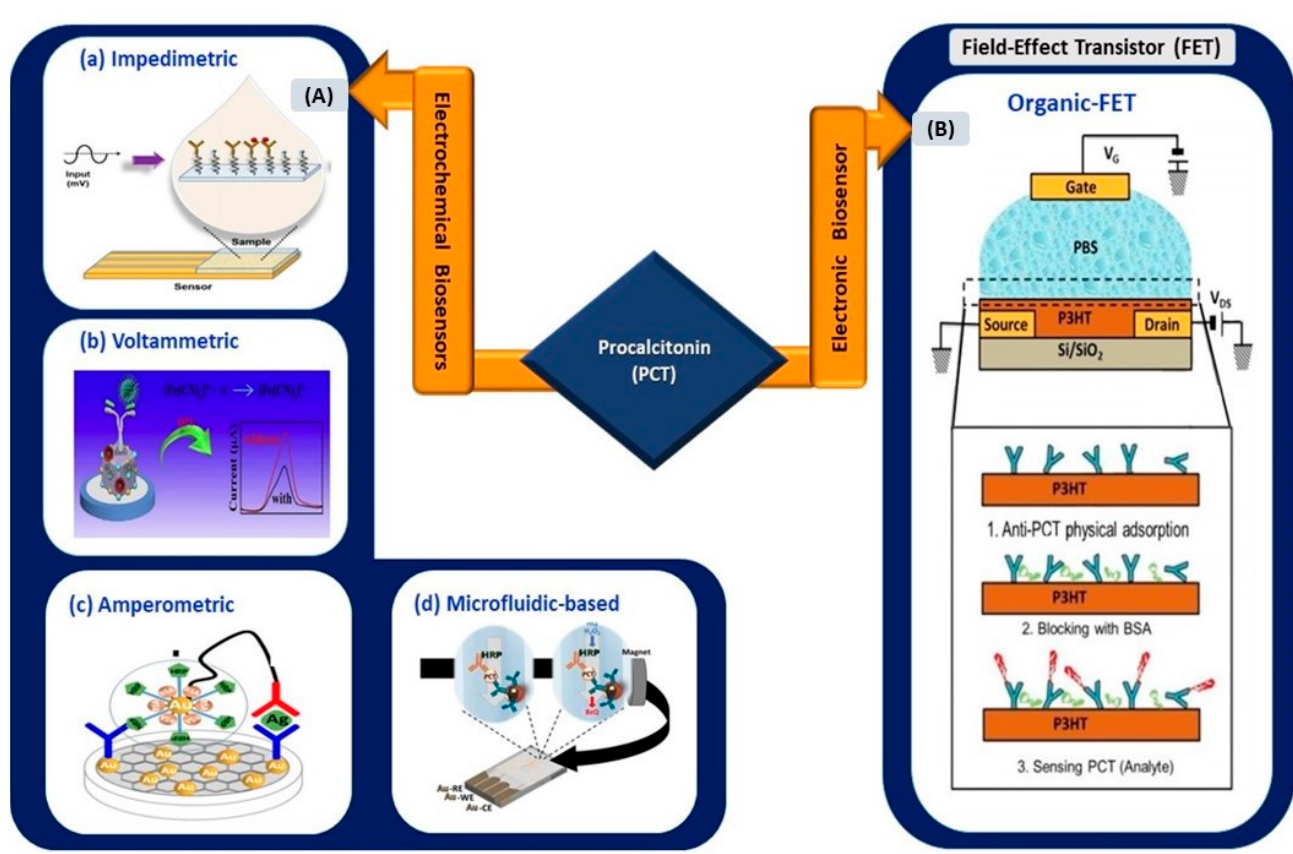
Figure 6. ( A ) Electrochemical biosensors: ( a ) impedimetric sensing of PCT using gold-interdigitated electrodes (reprinted from [98]), ( b ) nanocube-based voltammetric sensor (reprinted with permission from [100]), ( c ) nanocomposite-based amperometric PCT sensor (reprinted with permission from [102]), and ( d ) magneto immunoassay-based microfluidic PCT sensor (reprinted with permission from [99]). ( B ) Organic FET-based electronic biosensor for the detection of PCT (reprinted with permission from [96]).